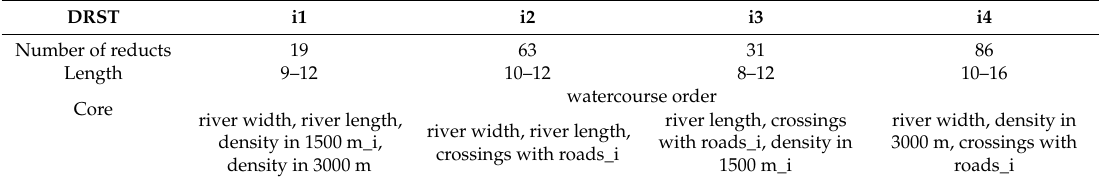
Table 15. Number, size, and cores of designated reducts designated using the DRST method for the selection of sections of watercourses to the scale of